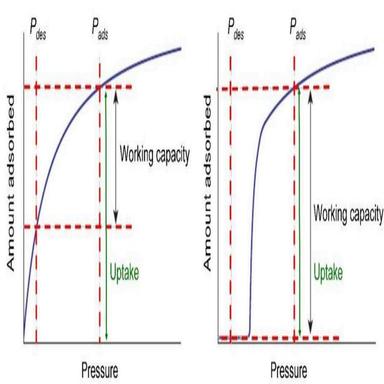
Schematic illustrating how the working capacity can differ between adsorbents with the same uptake but with two distinct isotherm types. Left: a type-I isotherm as exhibited by most rigid microporous sorbents, right: a type F-IV isotherm as found in flexible sorbents that can switch between closed (non-porous) and open (porous) phases.